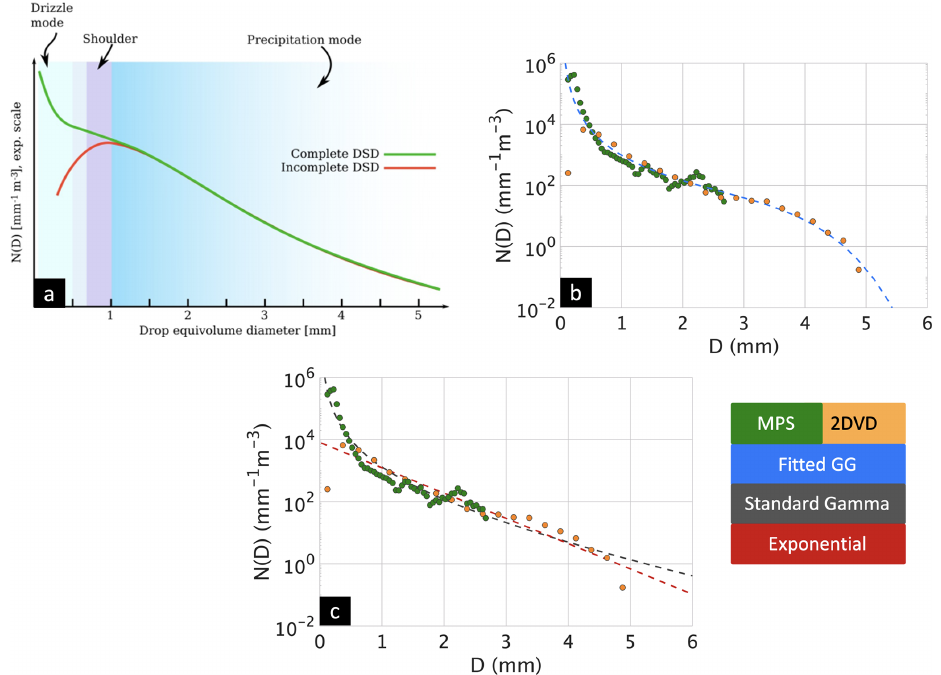
Figure 1. (a) Conceptual illustration of the complete DSD comprising the drizzle mode, the “shoulder” region, and the precipitation mode. The incomplete DSD is due to drop truncation by instruments that cannot measure the concentration of small drops. (b) An example of measured 3min averaged DSD ( R ≈ 60mmh − 1 ) using a collocated optical array probe with a 2DVD showing the separate measurements (note the high resolution of the MPS and the drop truncation of the 2DVD). The composite or compete spectrum is obtained by using the MPS for D ≤ 0 . 75mm and 2DVD for D > 0 . 75mm. The dashed blue line is the G-G fit (with parameters µ = − 0 . 3, c = 6; see Eq. (1) for details) to the complete spectrum. Data from the 23 May 2015 case study at 20:45UTC. (c) Same data points as panel (b) but with the standard gamma (black) and exponential (red) fits.